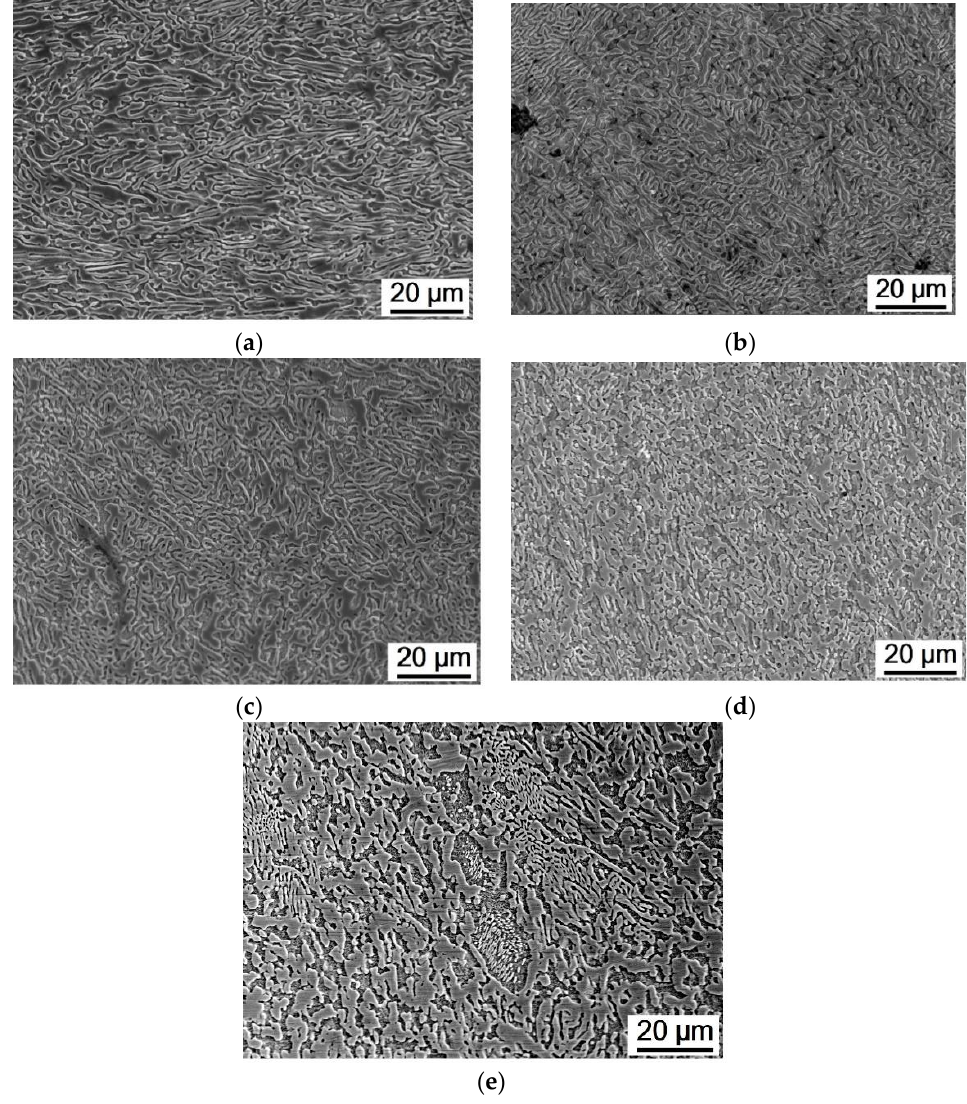
Figure 1. Microstructure of the Bi – Sn samples in ( a ) the as-cast condition and after t-HPS processing for ( b ) 0.25, ( c ) 1, ( d ) 5 and ( e ) 20 turns and storage at RT for 8 h.